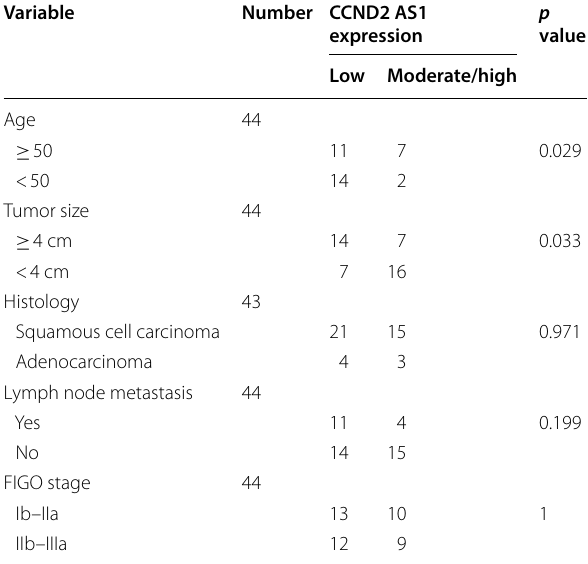
Table 1 Relationship between CCND2 AS1 expression in cervical cancer